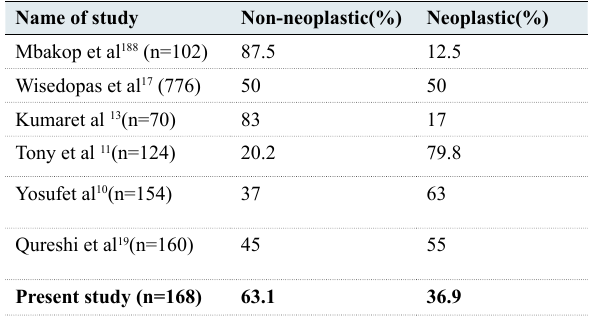
Table3. Comparative distribution of non-neoplastic and neoplastic